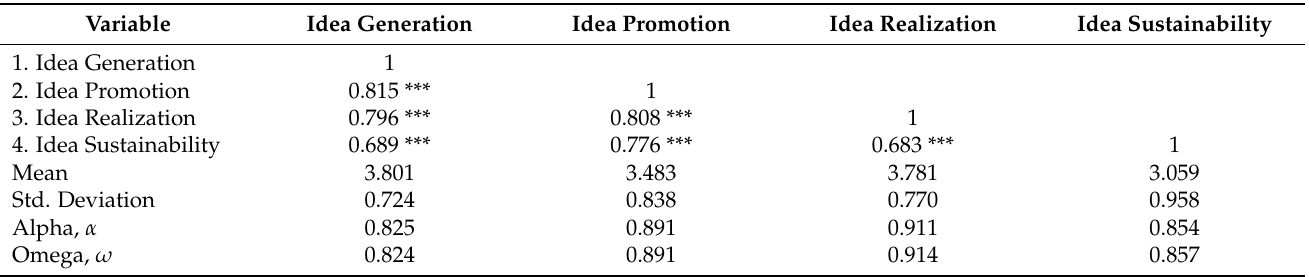
Table 4. Factor correlation matrix, means, standard deviations, and internal consistency measures, Cronbach’s alpha, and McDonald’s omega.